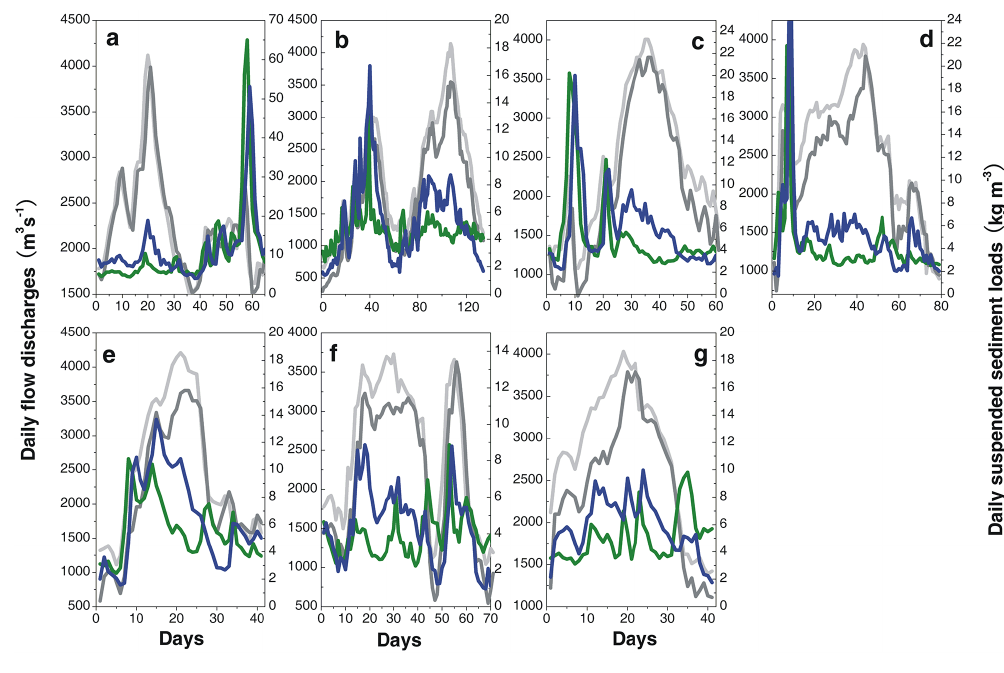
Figure 10. Daily suspended sediment loads and flow discharges of eight flow peaks (3500–4000m 3 s − 1 ) flowing through the Ulan Buh desert braided channel. (a) 3990m 3 s − 1 flow discharge peak on 20 July 1955; (b) 3550m 3 s − 1 flow discharge peak on 4 October 1963; (c) 3780m 3 s − 1 flow discharge peak on 23 September 1968; (d) 3790m 3 s − 1 flow discharge peak on 13 September 1976; (e) 3660m 3 s − 1 flow discharge peak on 19 September 1978; (f) 3630m 3 s − 1 flow discharge peak on 24 August 1983; (g) 3790m 3 s − 1 flow discharge peak on 5 August 1984. Light grey and grey lines are curves of flow discharges monitored in Shizuishan and Bayangaole gauges, respectively; olive and blue lines are curves of suspended sediment loads monitored in Shizuishan and Bayangaole gauges,